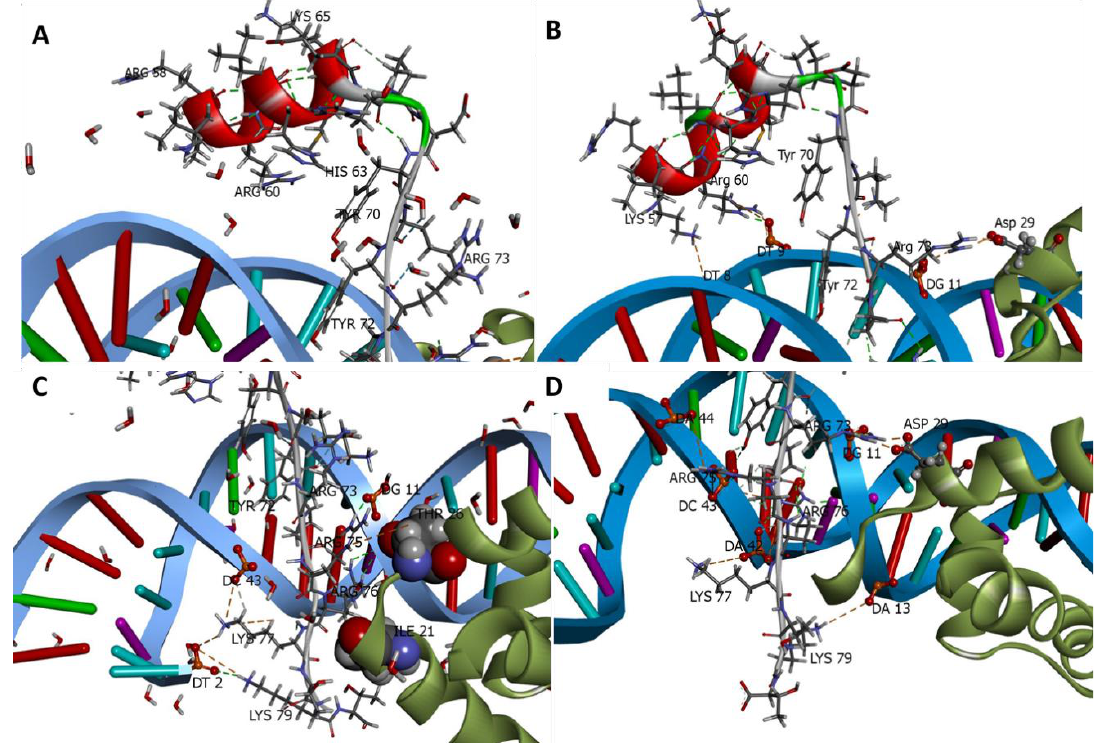
Figure 8. Interactions of residues in SOX2 (chain E) corresponding to the iPep in PDB entry 1GT0. The SOX2 region corresponding to the iPep is shown as ribbon and colored according to secondary structure. The FGF4-enhancer (DNA) and OCT4 are shown in blue and green ribbon representation, respectively. Hydrogen bonds, ionic interactions, and water-mediated interactions are shown by green, brown, and blue dotted lines. The phosphate backbones of certain nucleotides are shown as balls and sticks, whereas residues from SOX2 are shown as sticks. ( A ) Residues Lys57 to Tyr70 are involved in inter-residue interactions in the C-terminal helix of SOX2 and do not interact with DNA in the crystal structure. ( B ) During the MD simulations, the side chains of residues Lys57 and Arg60 from the SOX2 C-terminal helix form ionic interactions with DT8 and DT9. ( C ) Ionic interactions between SOX2 (residues Tyr72-Thr80) and DNA in the crystal structure are highlighted. Ile21 and Thr26 of OCT4 (shown as CPK) are known to form non-bonded interactions with Arg75 and Arg76 of SOX2. ( D ) Ionic interactions between SOX2 (Tyr72-Thr80) and DNA in a representative snapshot from the MD simulations. A transient ionic interaction is observed between Asp29 of OCT4 and Arg73 of SOX2. Residue numbering is based on the crystal structure of SOX2.